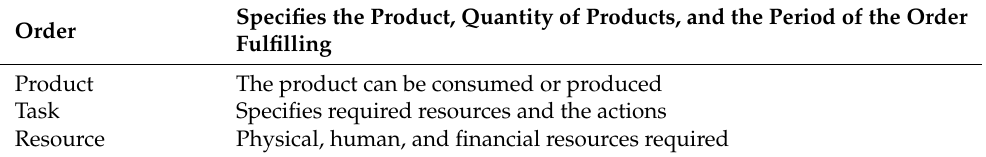
Table 2. Basic ontology objects for the allocation of resources to